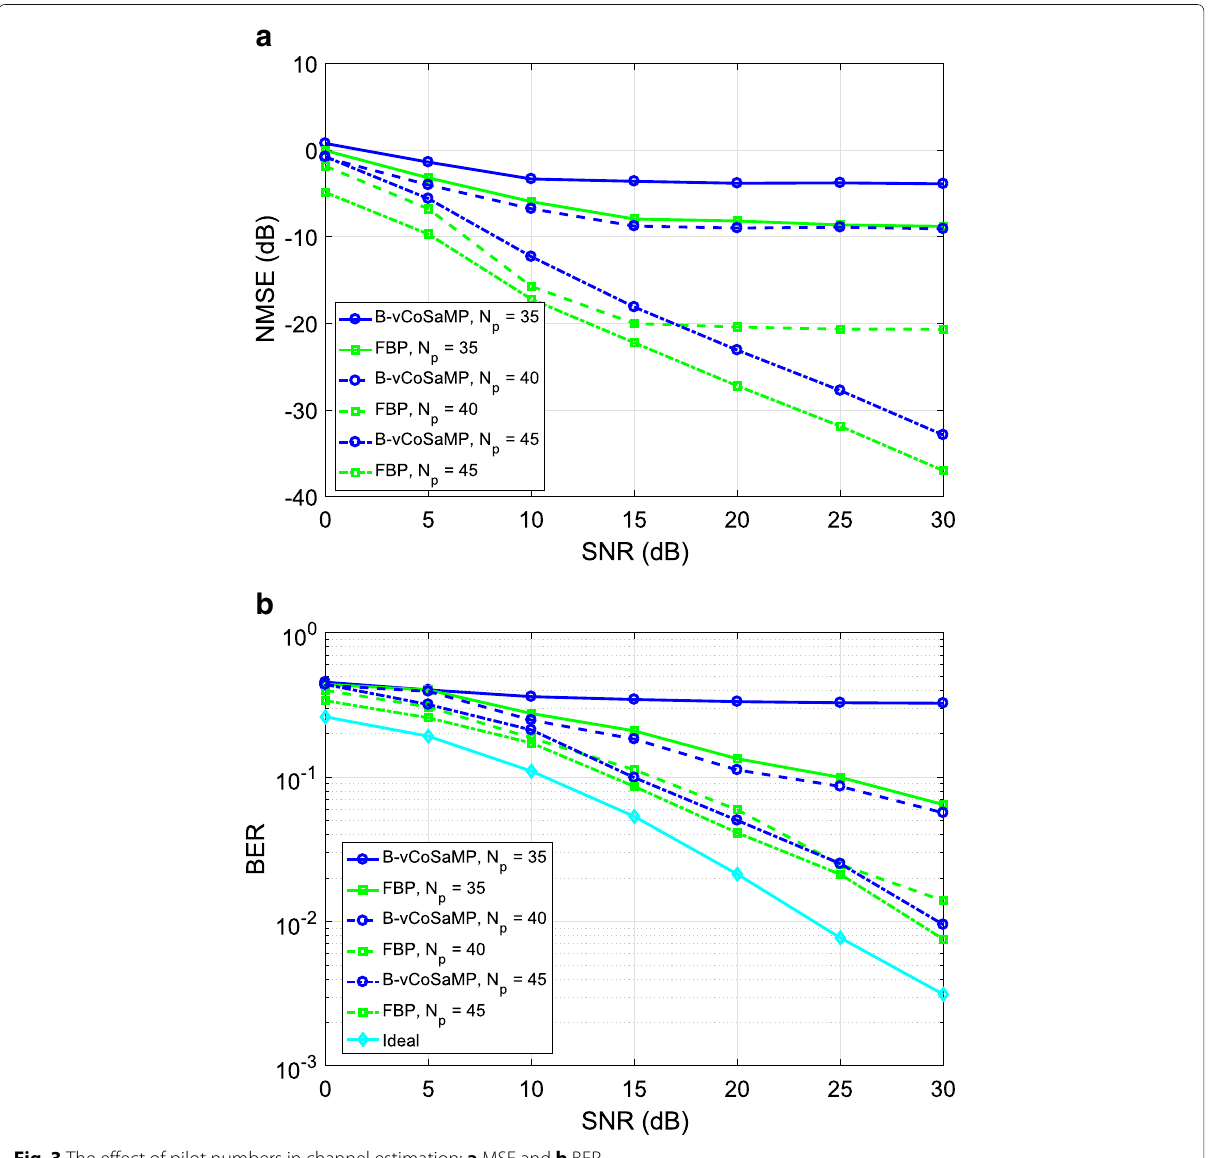
Fig. 3 The effect of pilot numbers in channel estimation: a MSE and b BER